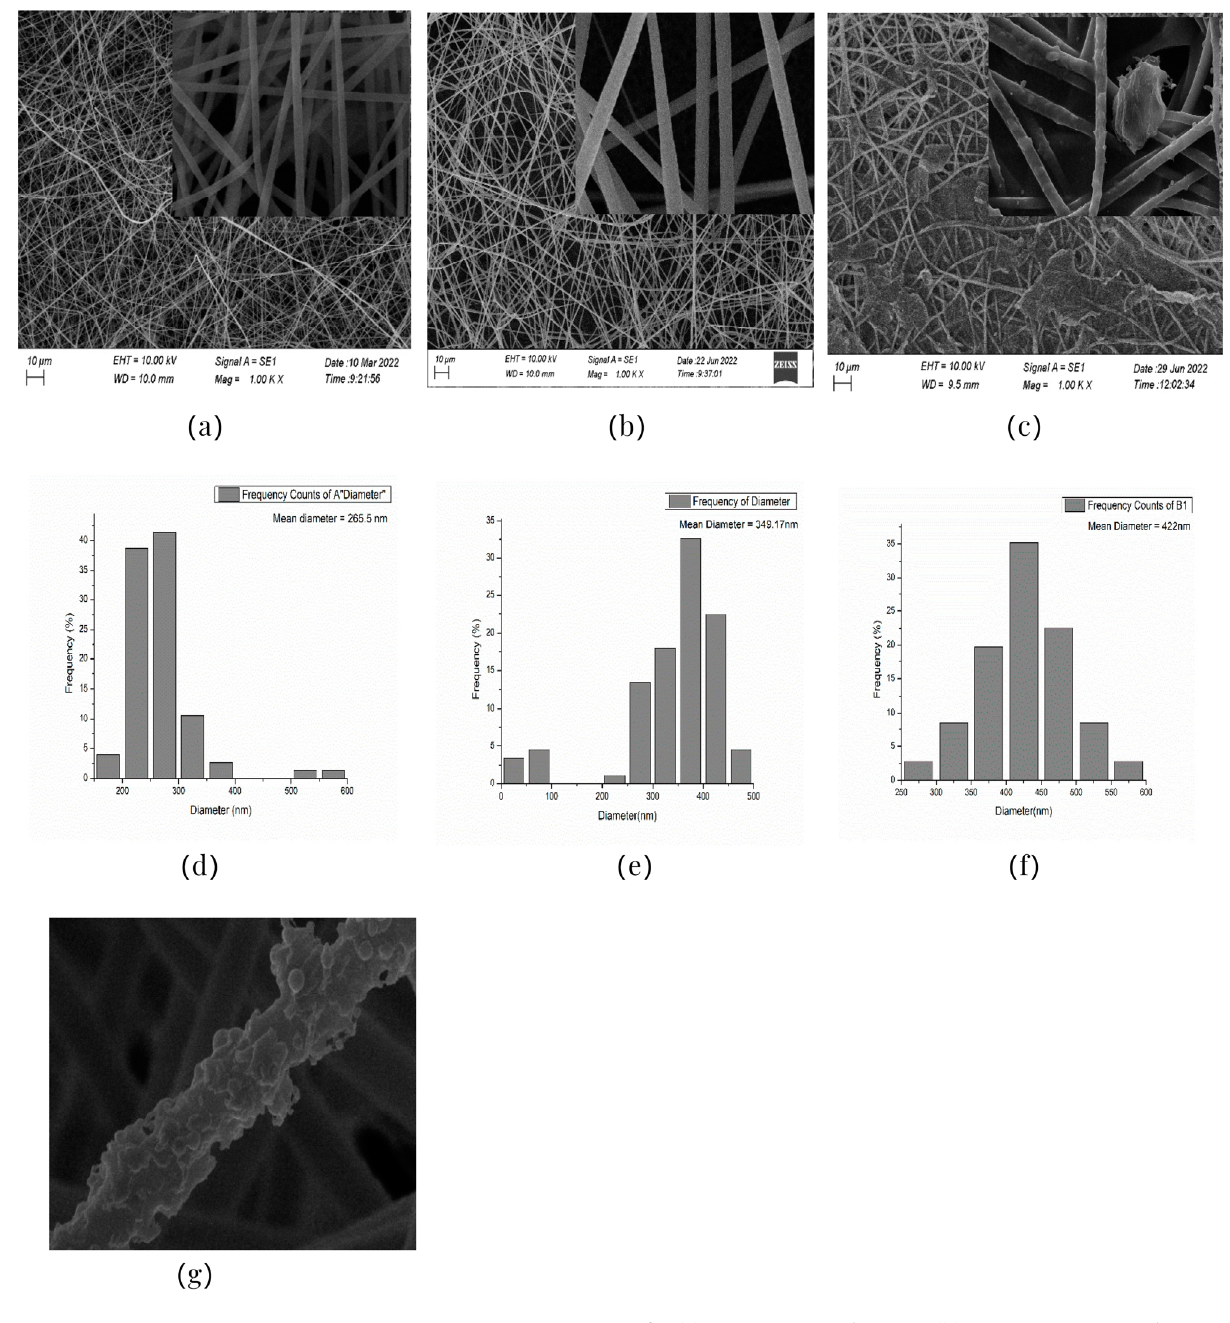
Figure 5. SEM images of ( a ) PAN membrane ( b ) PAN–EN membrane and ( c ) CS–GO-electrosprayed PAN–EN membrane; histograms of ( d ) PAN membrane and ( e ) PAN–EN membrane ( f ) CS–GO-electrosprayed PAN–EN membrane; SEM images of ( g ) magnified nanofiber of CS–GO-electrospun PAN–EN membrane.